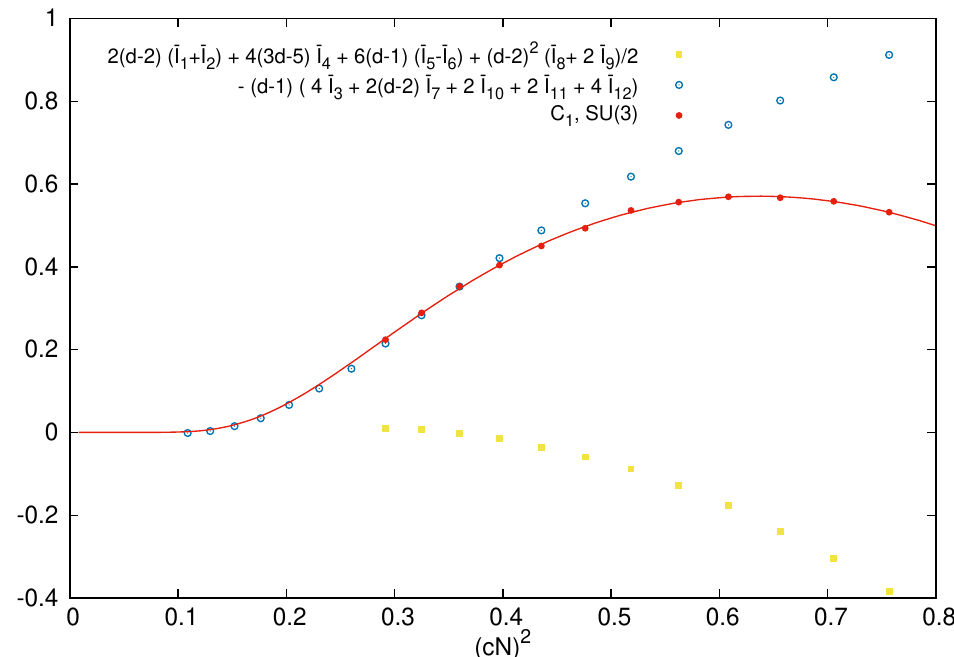
Figure 7. Dependence on cN of the SU(3) one-loop matching constant C 1 . The continuous line is a (cid:12)t to the functional form f ( cN ) = e (cid:0) ( cN ) (cid:0) 2 ( (cid:11) + (cid:12) log( cN ) + (cid:13)cN + (cid:14)c 2 N 2 ). We separated the contribution to C 1 into two pieces, plotted with open circles and squares.